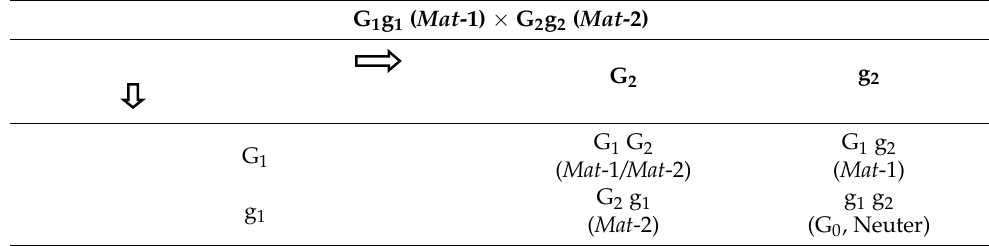
Table 6. Mendelian segregation of sexual compatibility types in two distinct self-sterile heterothallic